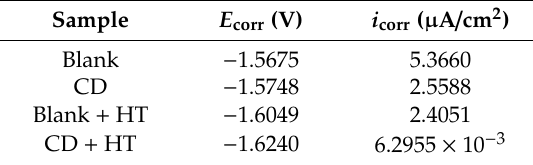
Figure 6. Nyquist plots for typical samples in 3.5 wt % NaCl solution.